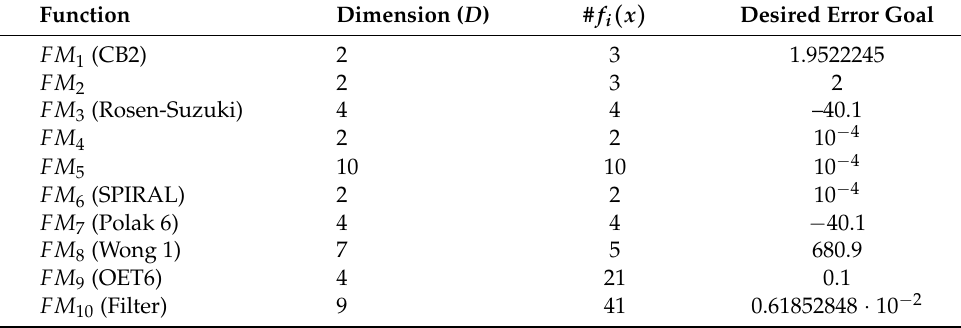
Table 1. Properties of the minimax test problems FM 1 – FM 10